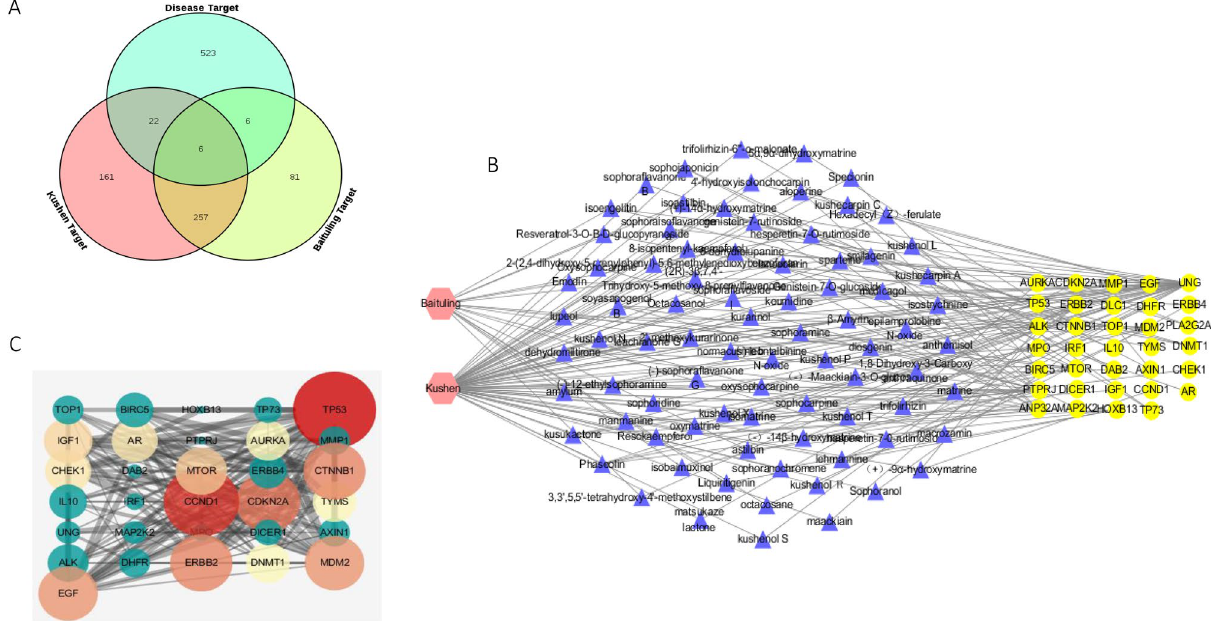
Figure 2. Network pharmacological analysis of targets, networks, and PPI. ( A ) Venn diagram of potential targets of CKI for CRC. The analysis and image was performed using the OmicShare tools, a free online platform for data analysis. ( B ) “Herb-active ingredient-protein target” network for CKI. The pink nodes represent herbs in CKI. Blue nodes represent potential drug targets. Yellow nodes represent active compounds. The edges represent interactions among them. The image was created using Cytoscape 3.7.1 software. ( C ) Protein interaction network of targets of CKI for the treatment of CRC. Each node represents the relevant gene. The edge means line thickness, which indicates the strength of data support. Hubs of top 14 genes in the PPI network are expressed in colors other than green. The depth of the colors and the size of the circle represent the degree. The image was created using STRING 10.5